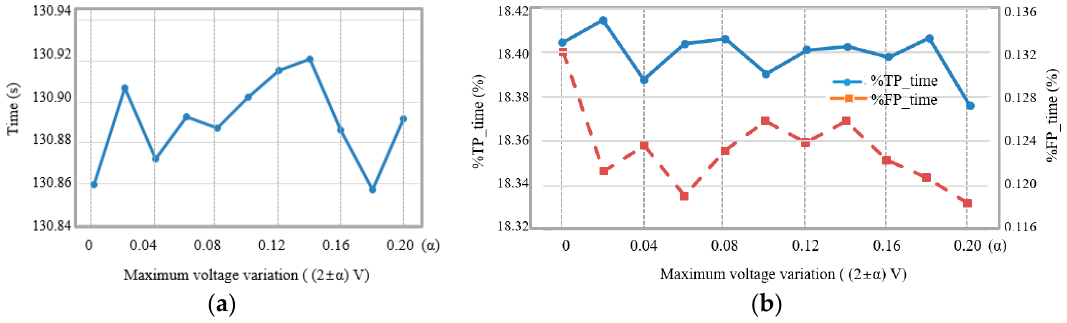
Figure 13. ( a ) Average detection time and ( b ) average % TP_time and % FP_time according to irregular variations of the supply voltage.